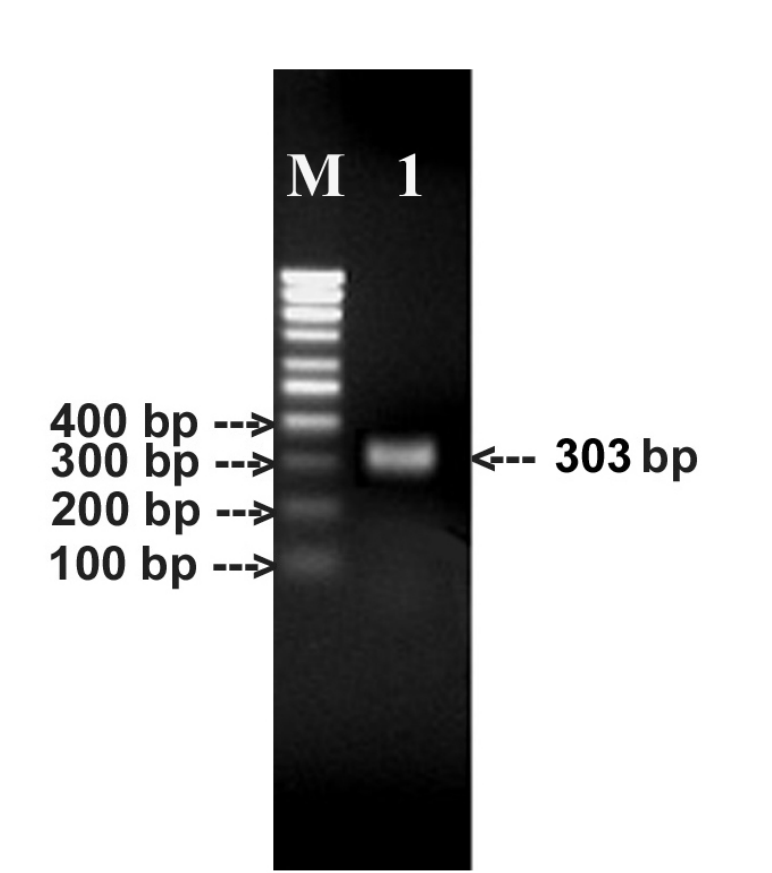
Figure 7. Amplification of the conserved region of the cytolysin gene by RT-PCR. M: 100 bp DNA ladder; lane 1: 303 bp amplified product code for the conserved region of Hmg III.